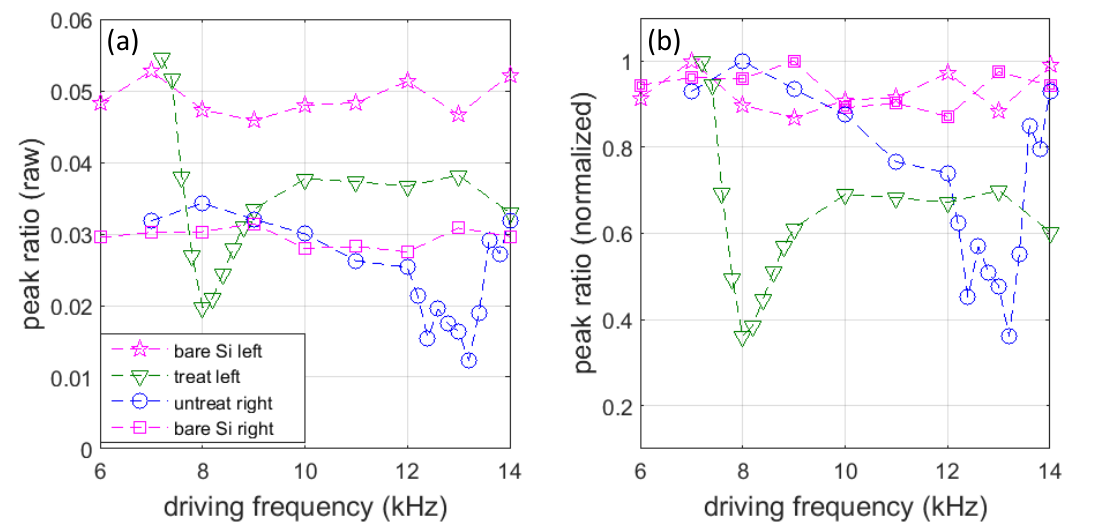
Figure 9. Valley frequencies of untreated, treated Pt-Ti specimens and bare Si specimens. ( a ) Raw data of peak ratio; ( b ) normalized to the bare Si data for the respective mirrors, i.e. , the Pt-Ti specimen data obtained with the right/left mirror to bare Si data with the right/left